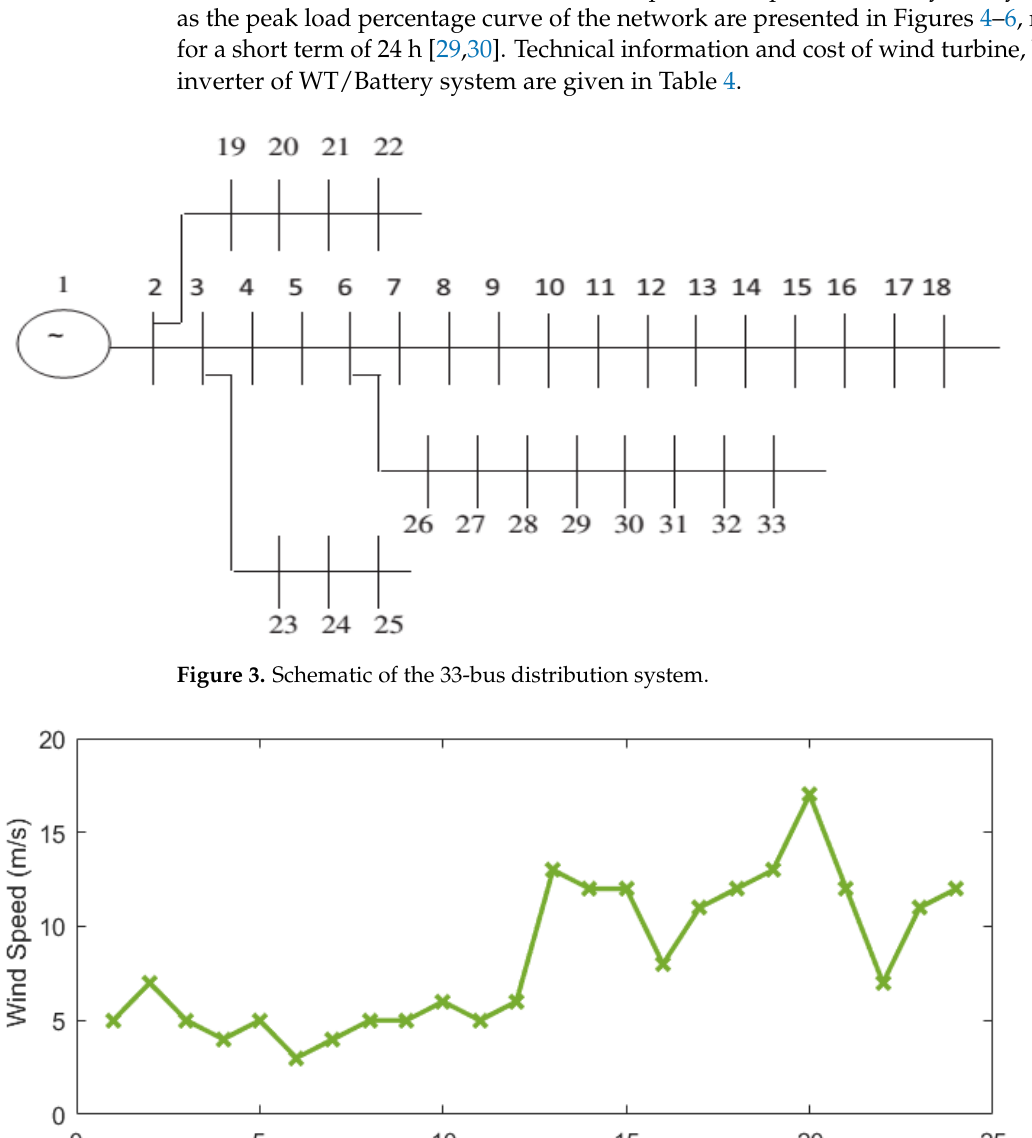
Figure 5. Profile of hybrid system demand during a day. Figure 6. Percentage of network peak load during a day. Table 4. Technical information and cost of wind turbine, battery, and inverter of WT/Battery system [40].